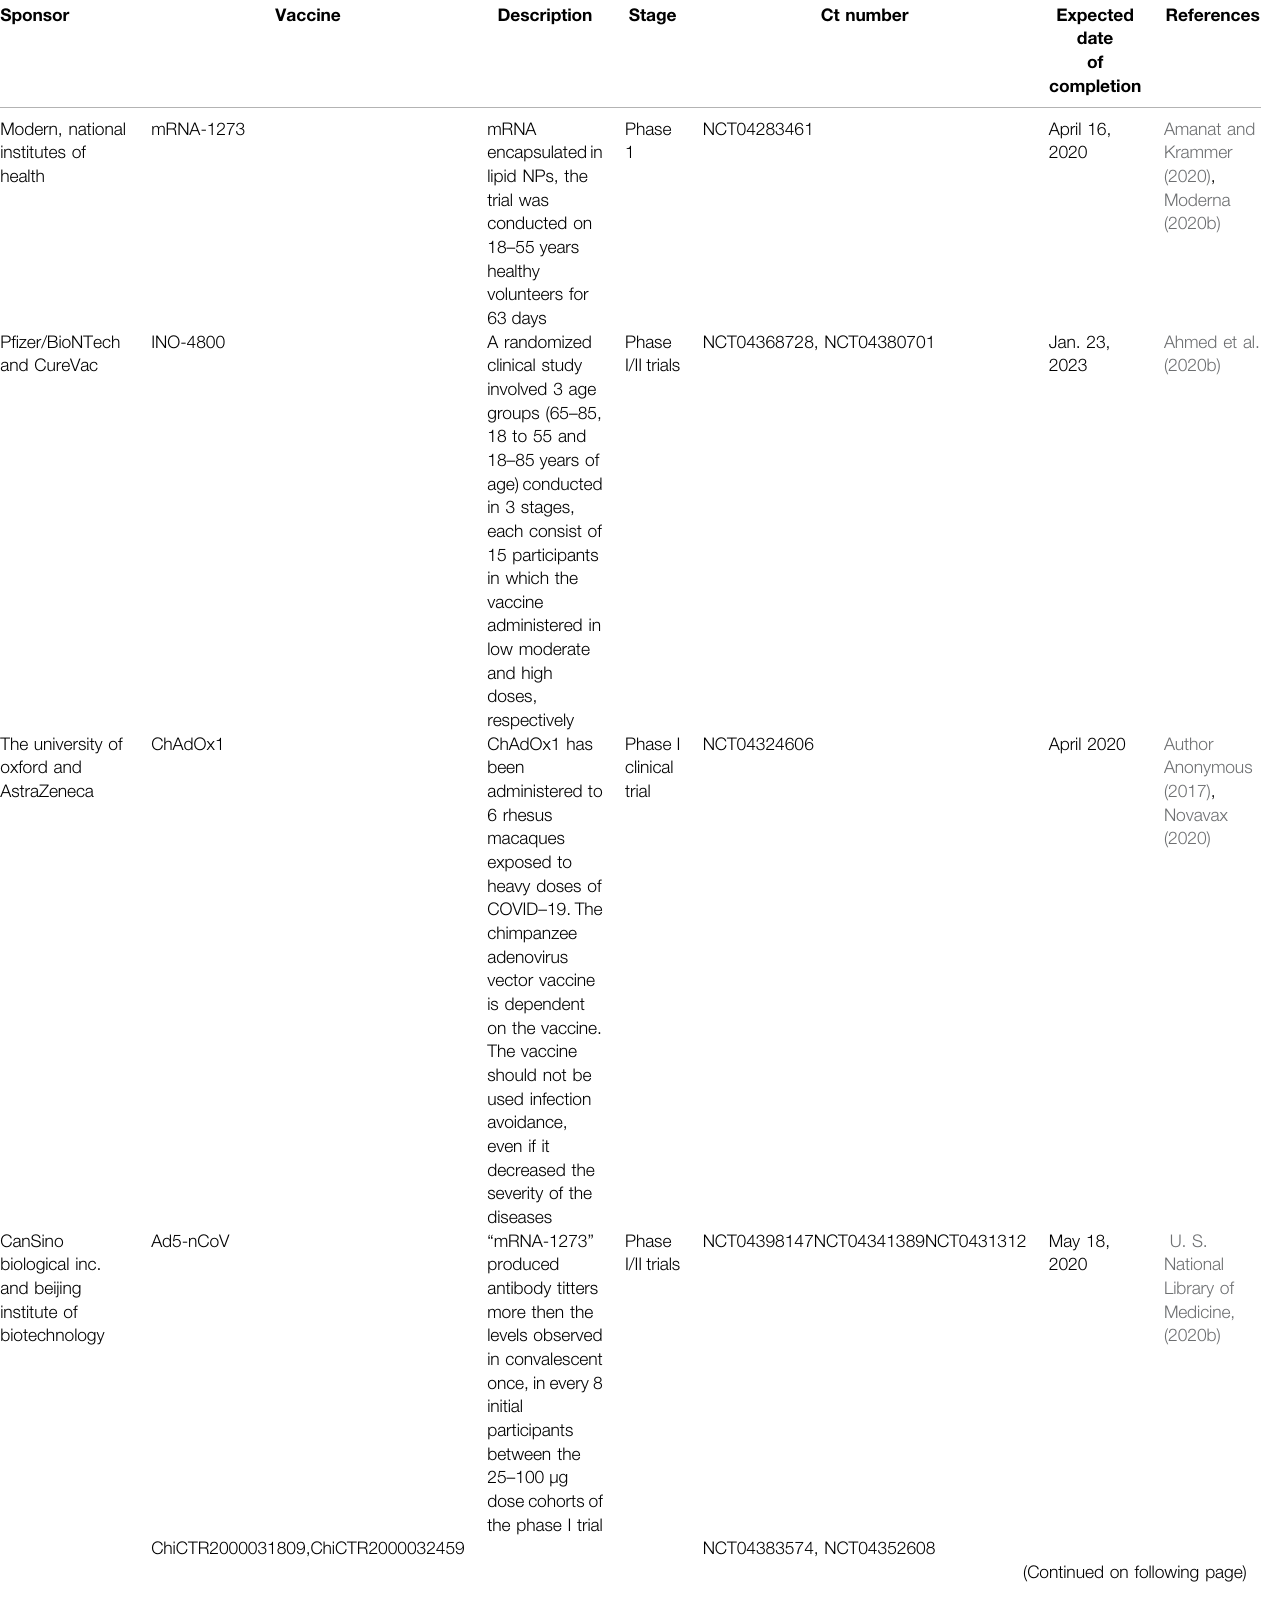
TABLE 3 | Nanotechnology-based